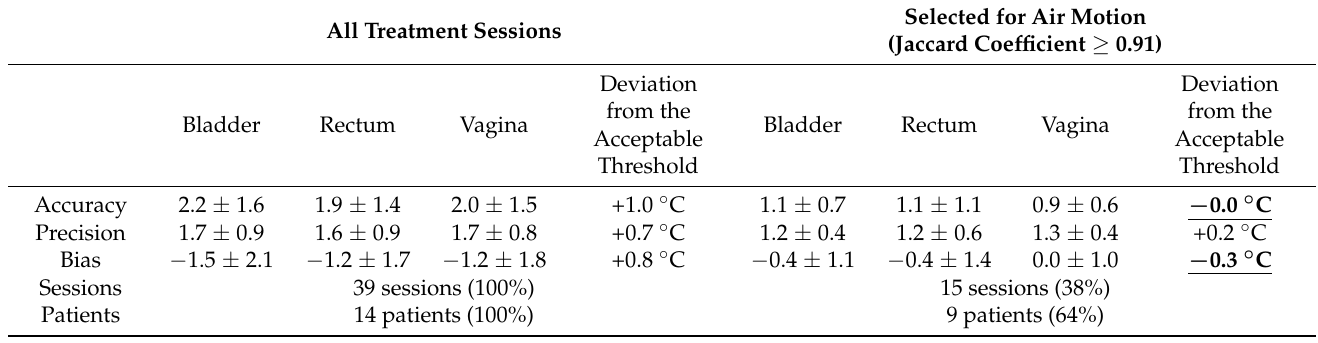
Figure 6. Evaluation of MR thermometry accuracy in ( a ) all treatment sessions and ( b ) in the group of selected treatment sessions. The MR thermometry was calculated for the three intraluminal locations. The evaluation of MR thermometry was based on the voxels remaining after filtering and data used in the analysis. The dashed red line represents the acceptable mean accuracy threshold (1 °C) and, in light red circles, the mean MR thermometry accuracy in each location. The inter-quartile range denotes the middle 50% of the dataset. The top box shows 75% of the dataset that falls below the upper quartile, while the bottom line consists of 25% of the dataset that falls below the lower quartile. The middle line represents the median value, and the line extending from the box represents 2.5% and 97.5% limits of the dataset. Table 2. Accuracy, precision, and bias parameters of MR thermometry in all treatment sessions and the selected dataset based on the Jaccard coefficient threshold equal to 0.91. All evaluation parameters are expressed by the mean ( µ ) ± standard deviation ( σ ); these mean values are also indicated in light red circles in Figures 6 and 7. The number of sessions and patients remaining after exclusion are indicated. In addition, the average deviation from the acceptable threshold is given for accuracy (1 ◦ C), precision (1 ◦ C), and bias ( ± 0.5 ◦ C). The equal values or below the acceptable threshold are in boldface and